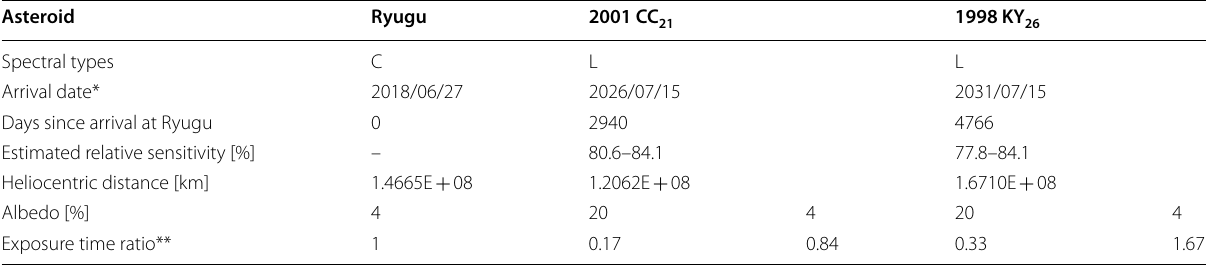
*Because the exact arrival date has not yet been determined, we chose a date near the middle of the expected arrival